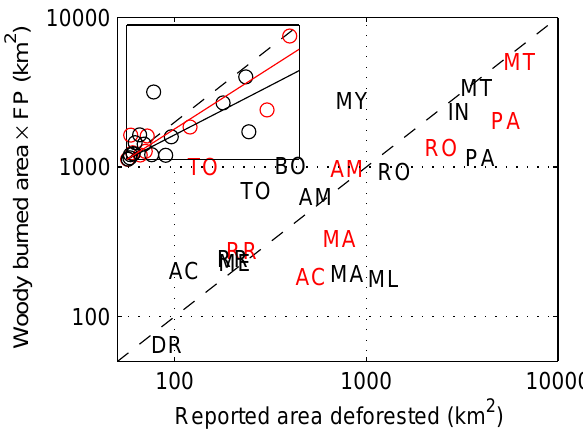
Fig. 3. Comparison of modeled deforested area with estimates from PRODES for states in the Brazilian Amazon (red, total for 2001–2006) and from Hansen et al. (2008) for tropical forest coun- tries (black, total for 2000–2005). The dashed black line depicts the 1:1 slope. Modeled deforestation rates were based on a met- ric combining burned area in woody vegetation types with fire per- sistence (FP). Note the log scale; inset in top left shows the same data on a linear scale. The red solid line indicates the linear fit with PRODES data (slope of 0.75; R 2 = 0 . 78, n = 9), and black solid line shows the linear fit with Hansen et al. (2008) data (slope of 0.66; R 2 = 0 . 49; n = 15), both forced through origin. Modeled fire-driven deforestation rates were 82% of the total rates from the independent estimates. Abbreviations are DR (Democratic Repub- lic of Congo), ME (Mexico), BO (Bolivia), MY (Myanmar), ML (Malaysia), IN (Indonesia), and the Brazilian states of AC (Acre), RR (Roraima), AM (Amazonas), RO (Rˆondonia), PA (Par´a), and MT (Mato